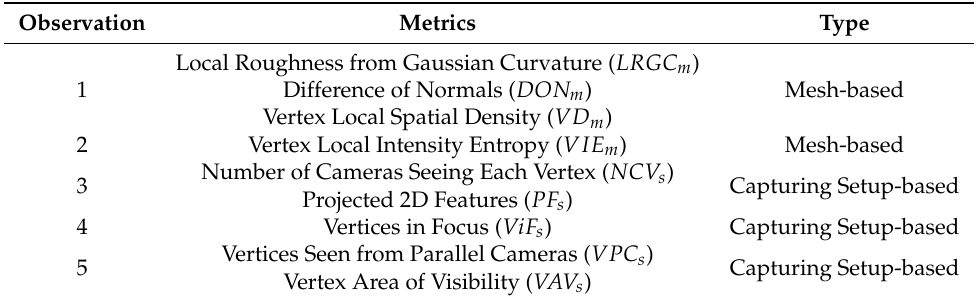
Figure 3. Examples of the five main observational hypotheses, used as a basis for the chosen mesh-based and capturing setup-based metrics. Table 1. The five observational hypotheses and the chosen metrics, used to describe them. The different metrics are either based only on the reconstructed mesh itself or on the capturing setup—camera positions, intrinsic parameters,